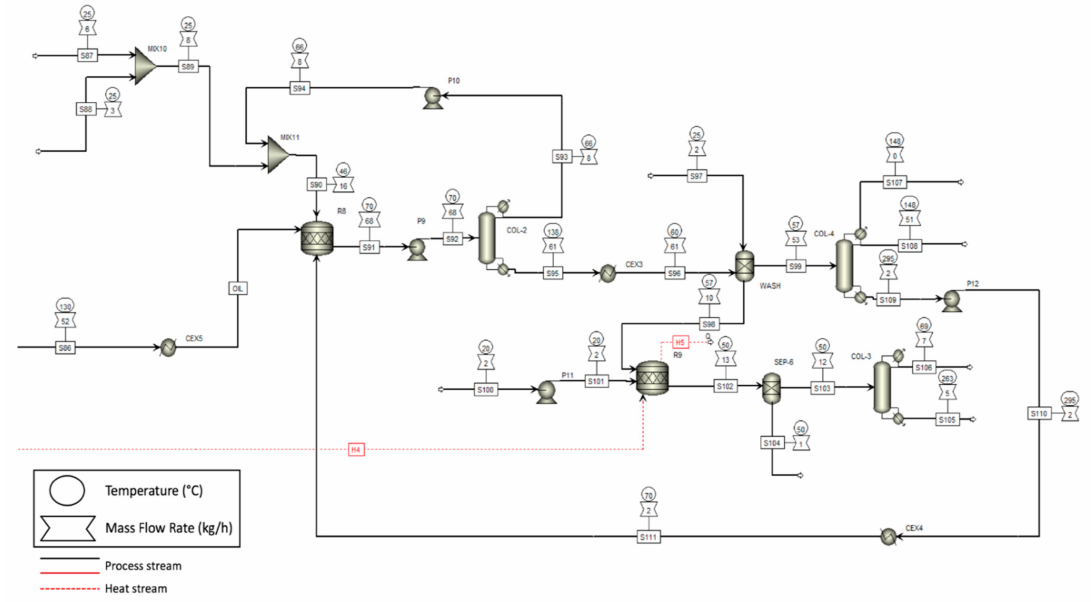
Figure 5. Flowsheet of transesterification as simulated using Aspen